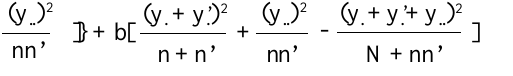
Table I - Analysis of variance of partial diallel involving parents and their F arranged in a randomized complete block design. Source of variation Degrees of